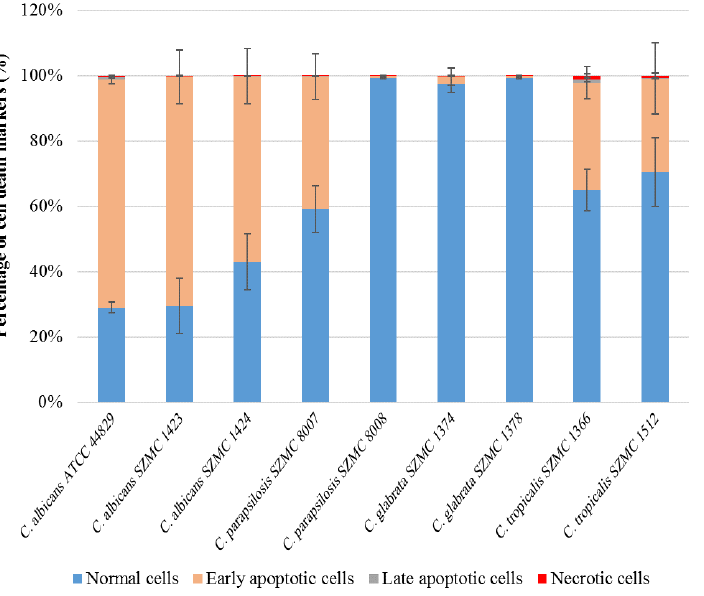
Figure 4. Cell death induced by CAPE treatment in nine Candida strains as determined by annexin V and PI staining. Data are shown as mean ± SD from three independent experiments.